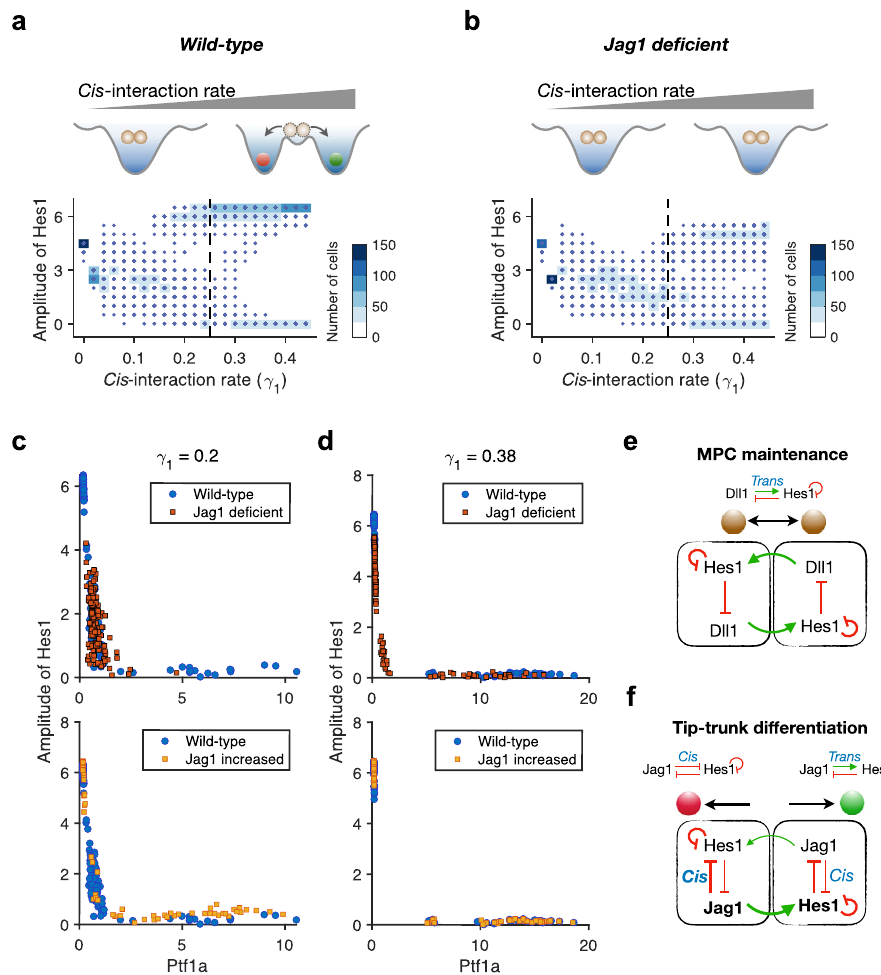
Fig.6|Jag1bifurcatescellfatesbymediatingstrong cis -interaction.a Summary schematic diagram for the necessity of cis -interaction in pancreatic cell fate seg- regation. Successful cell fate bifurcation requires a certain level of cis -interaction. The heatmap shows the distribution of amplitude of Hes1 in simulated pancreas with different cis -interaction rate. Each column corresponds to one speci fi c value of the cis -interaction rate. Cells maintain intermediate Hes1 oscillation amplitudes with low cis -interaction, while either high or low Hes1 oscillation amplitudes